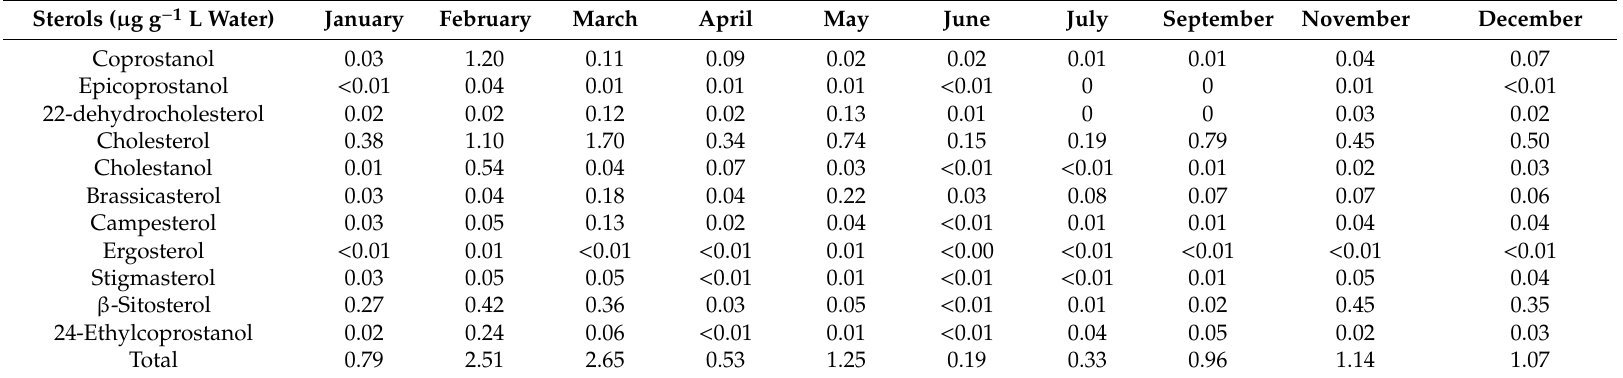
Table 2. Concentrations of 11 major sterols and total sterols ( µ g g − 1 L water) in water collected from above the oyster beds (Site 4) in Salcott Creek over 12